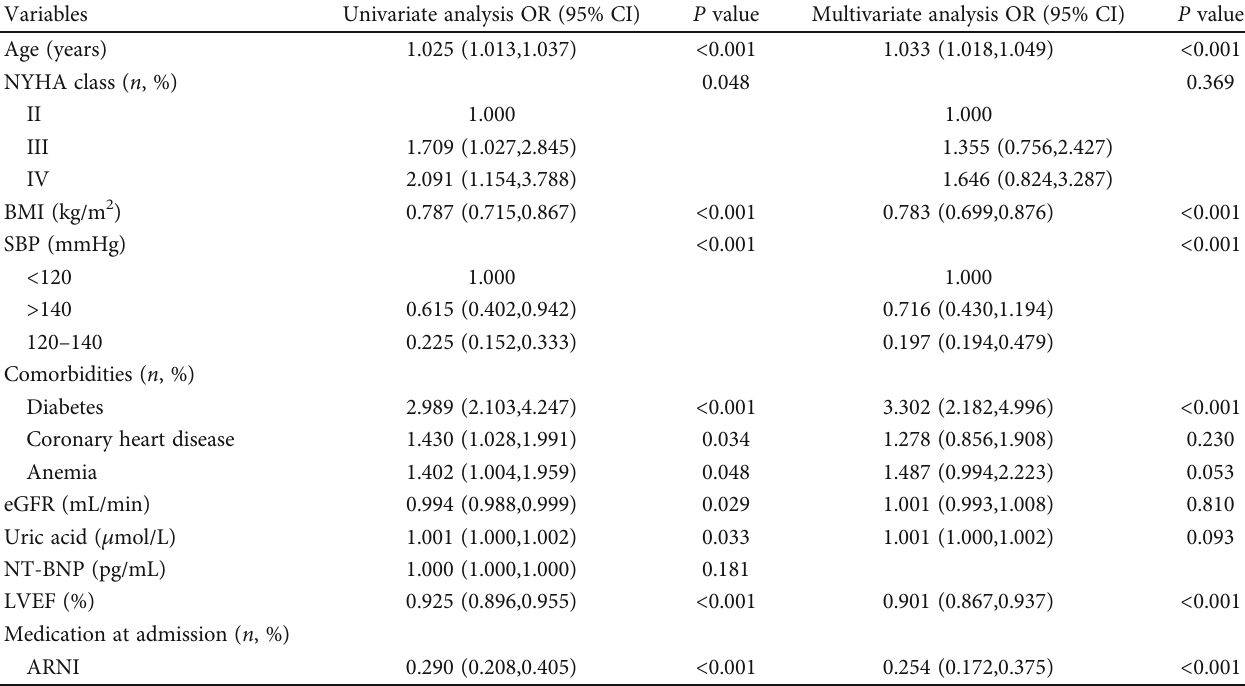
Table 2: Univariate and multivariate logistic analysis for the readmission within 1